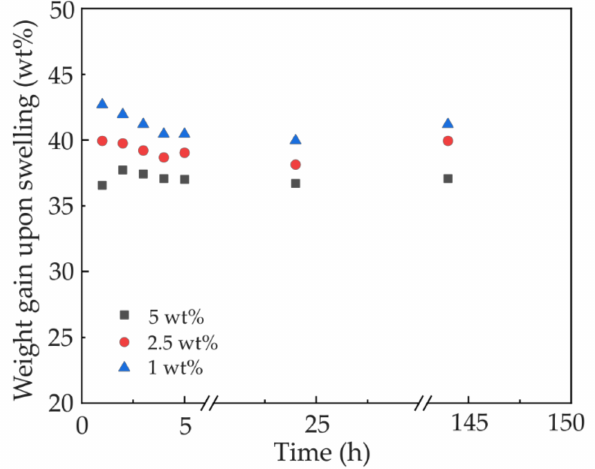
Figure 2. Weight gain upon swelling of pristine cured polydimethylsiloxane (PDMS) slabs, for 1, 2.5, and 5 wt% of Irgacure OXE02 in the DVB